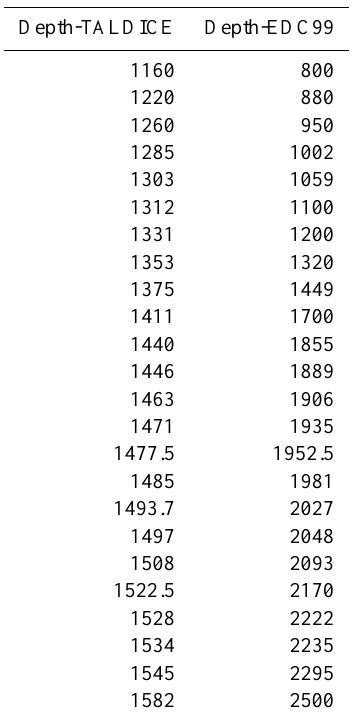
Table 3. CH 4 synchronisation tie points between EDC and TALDICE and corresponding 1 depth estimates at